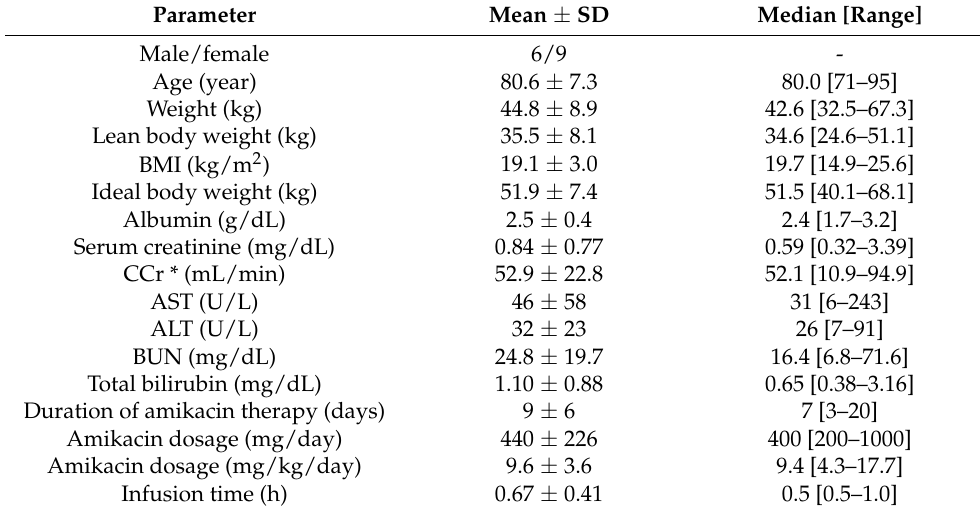
Table 1. Clinical characteristics and distribution of amikacin of hospitalized